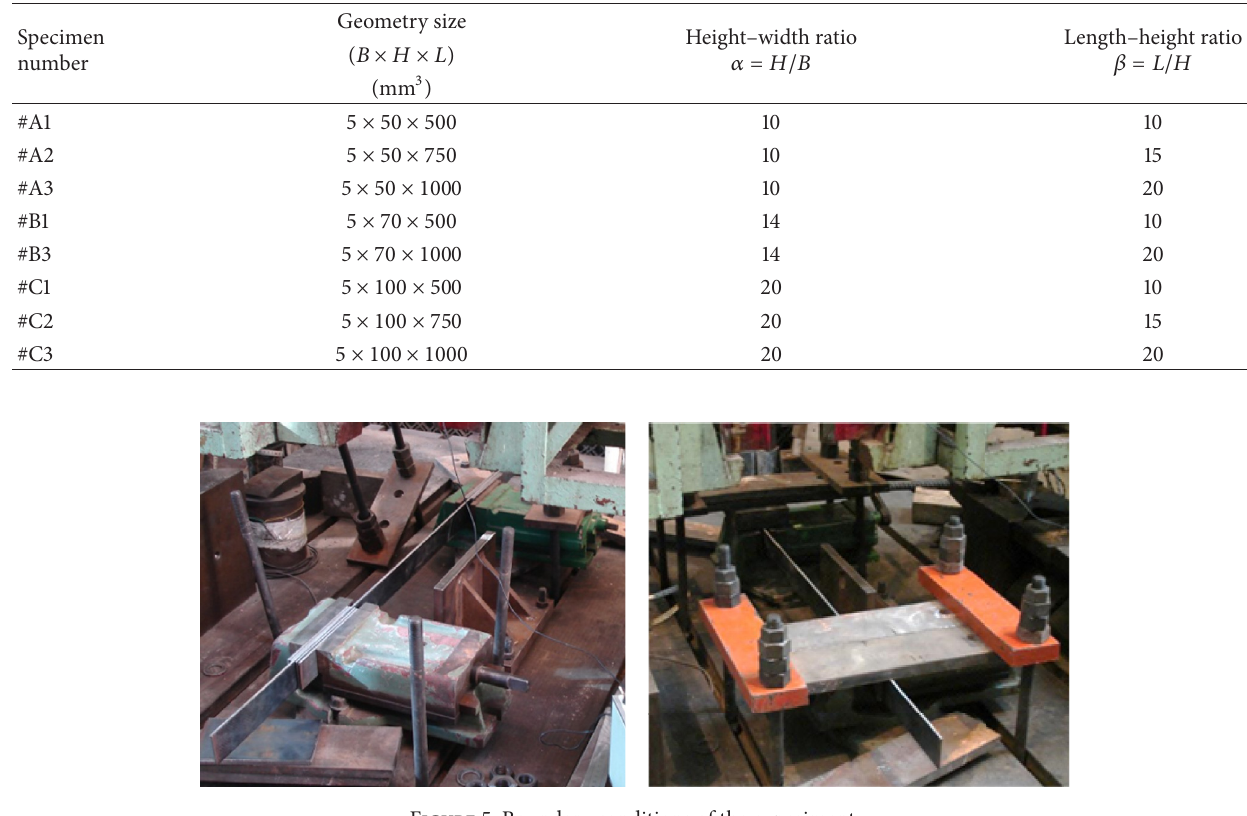
Figure 5: Boundary conditions of the experiment.